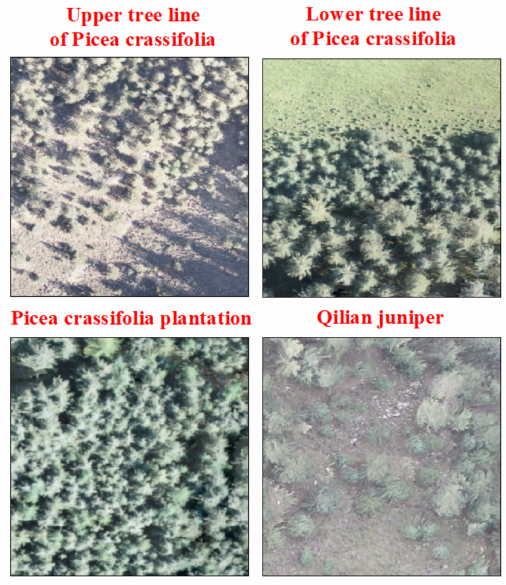
Figure 3. Verification data for drone sampling